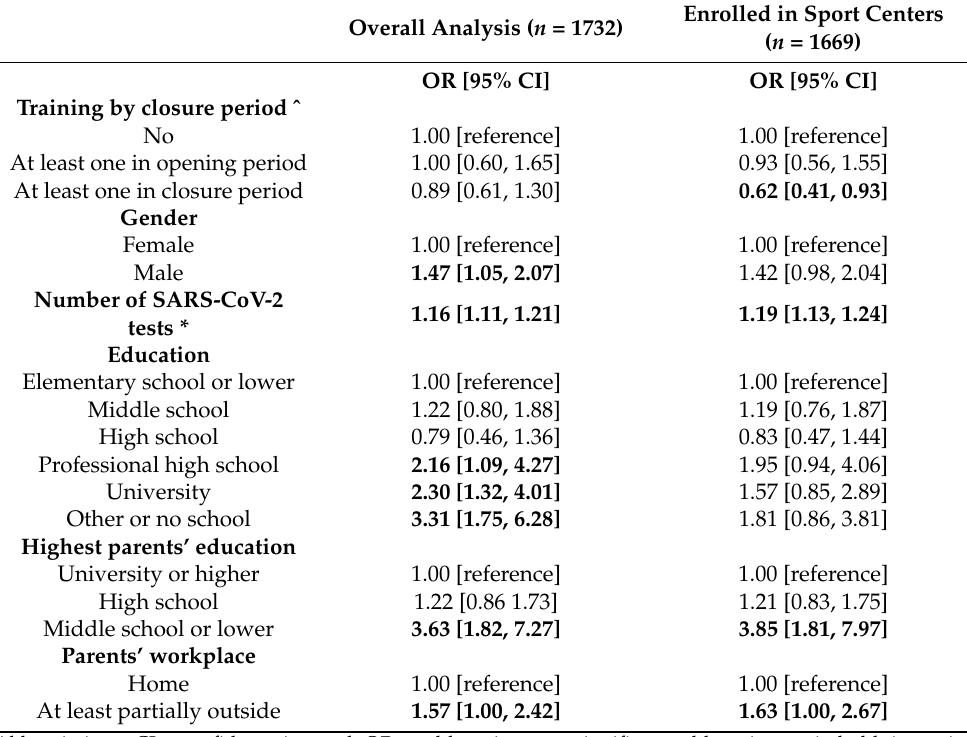
Table 2. Multivariable analysis for the risk of being tested positive for SARS-CoV-2 in the overall study population and in the subgroup of athletes enrolled in sports centers. Analysis comparing athletes with training sessions in opening and closing periods. Enrolled in Sport Centers Overall Analysis ( n = 1732) ( n = 1669) OR [95%